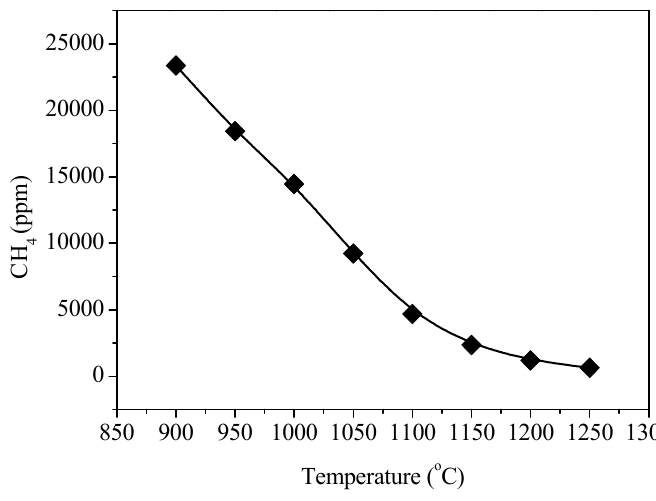
Figure 6. Simulation results of CH 4 yield at di ff erent temperatures.